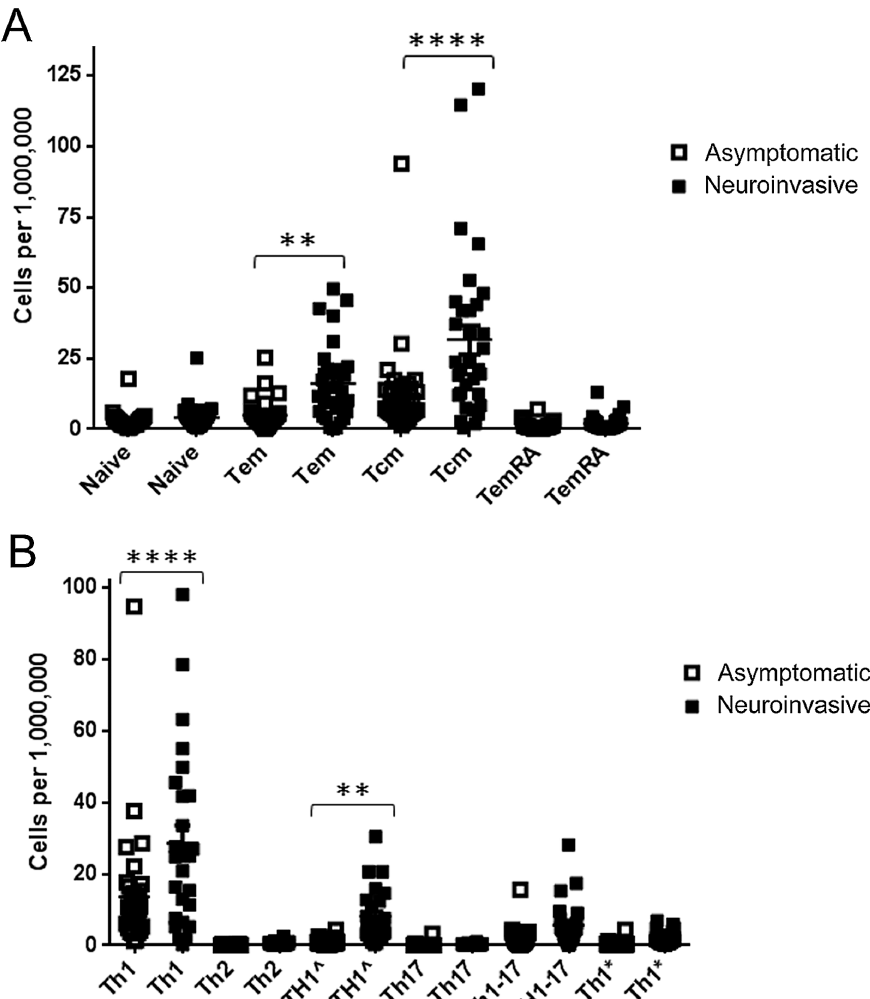
Fig 5. Comparing the absolute number of various subsets of WNV specific T cells in WNV subjects with neuroinvasive versus asymptomatic infection. A) Neuroinvasive subjects (9 subjects, designated by filled symbols) had higher numbers of WNV specific CD4+ T cells that were TEM or TCM (p < 0.0001 and p < 0.01 respectively) than asymptomatic subjects (11 subjects, designated by open symbols).